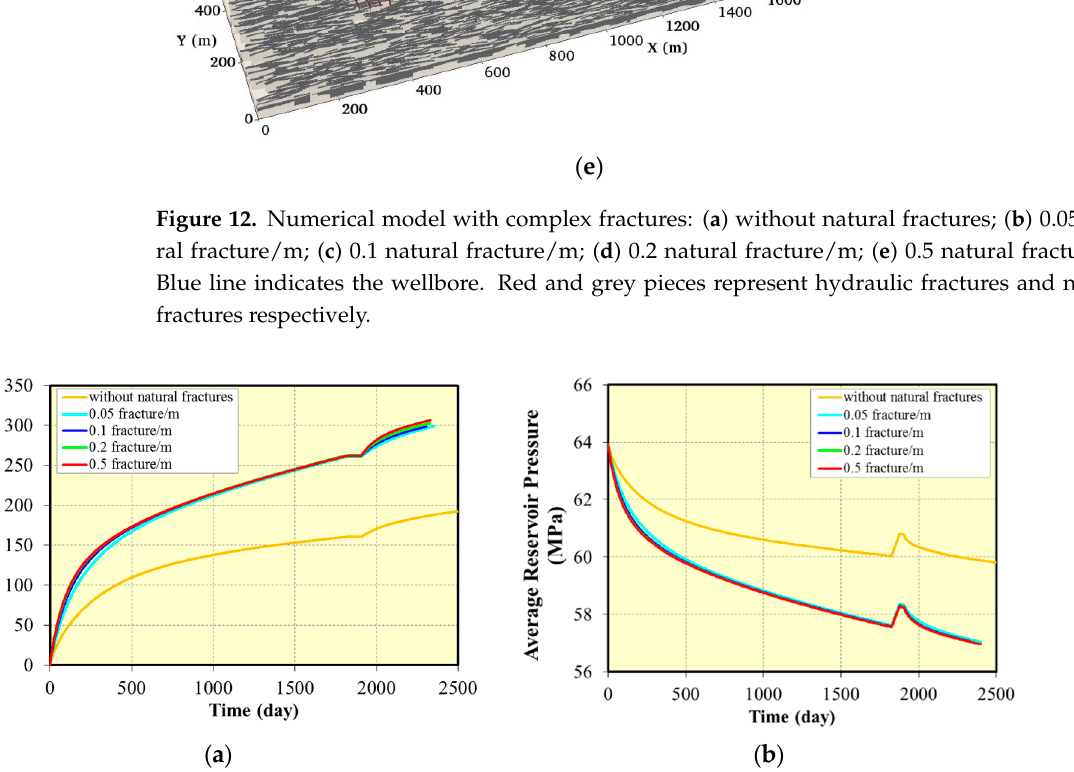
Figure 13. Effect of different natural fracture densities with one huff-n-puff cycle on oil production and reservoir pressure: ( a ) Cumulative oil production for different natural fracture densities; ( b ) Average reservoir pressure for different natural fracture densities.